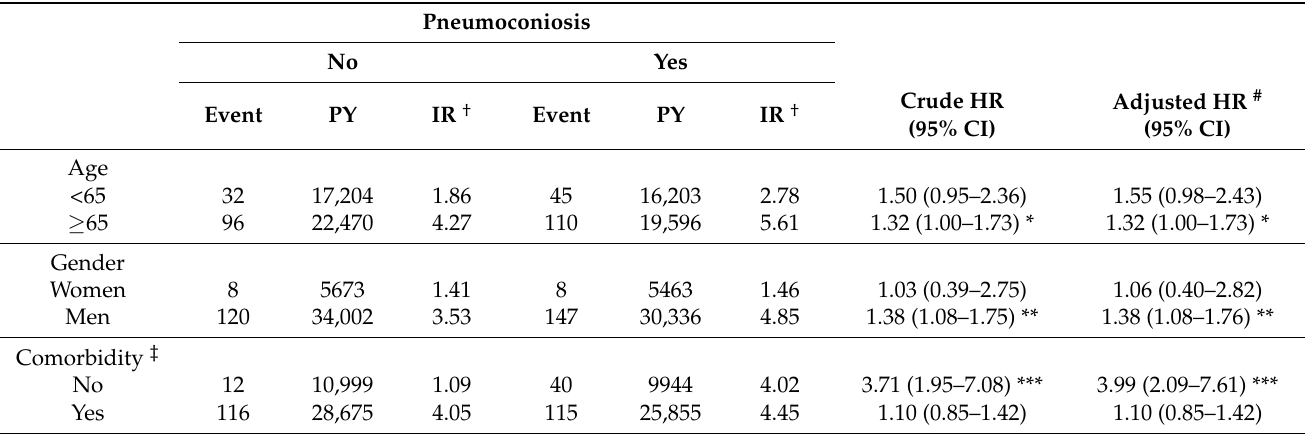
Table 3. Incidence rates and hazard ratios of acute myocardial infarction for the pneumoconiosis cohort (PC) compared to the comparison cohort (CC) by age, gender, and comorbidity. Pneumoconiosis